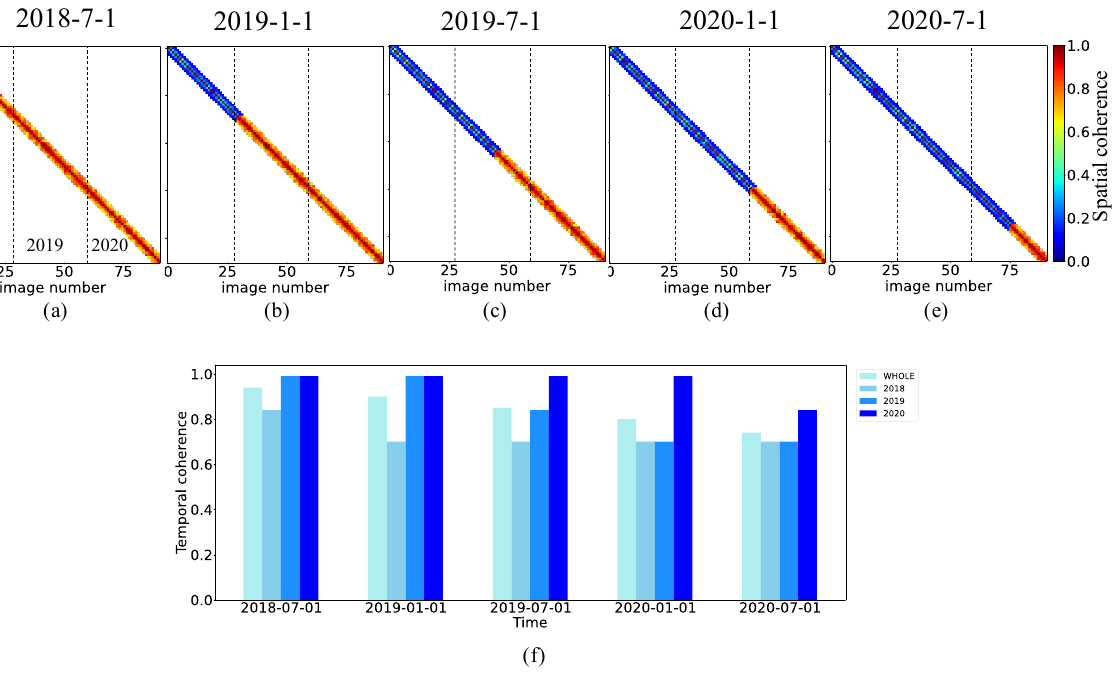
Figure 10. Simulation results of two decorrelation models. ( a )–( e ) Spatial coherence matrix for each model transition timing. ( a ) 1 July 2018. ( b ) 1 January 2019. ( c ) 1 July 2019. ( d ) 1 January 2020. ( e ) 1 July 2020. ( f ) Temporal coherence bar plot for both SUBSET and WHOLE. From the second and third analyses, it is shown that SUBSET enhances the RMSE when the optimal subset timing and lower are appropriately applied.